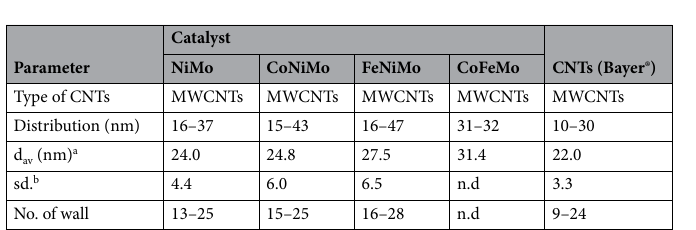
Figure 5. FE-SEM (× 50 k, 10 kV), HR-TEM (× 600 k, 300 kV) micrographs, and particle size distribution of synthesized CNTs over ( a ) NiMo, ( b ) CoNiMo, ( c ) FeNiMo, and ( d ) CoFeMo catalysts supported on MgO (Reaction conditions: 800 °C, 1 atm, 3 h.).